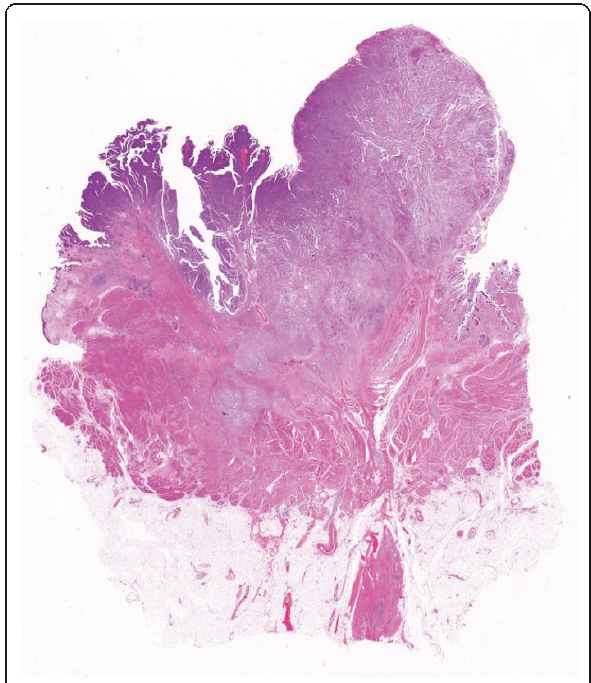
Figure 13 Urothelial carcinoma with muscolaris propria invasion